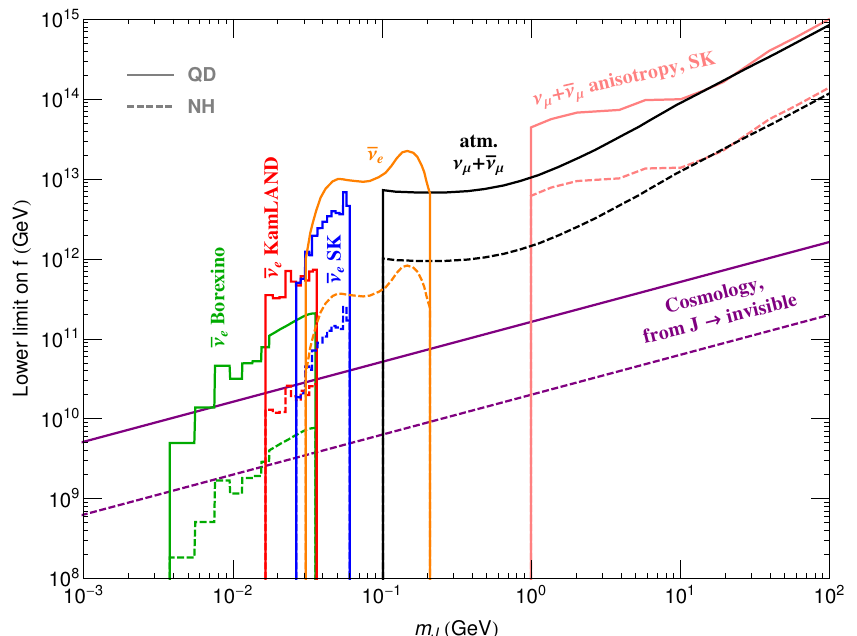
Figure 4 . Lower bound on the U(1) B (cid:0) L breaking scale f for majoron J DM, assuming QD (solid lines) or NH (dashed), IH lying in between. The purple exclusion comes from cosmological con- straints such as the CMB [60]. Adopted limits from supernova (cid:22) (cid:23) e searches come from Borexino [32] (green), KamLAND [33] (red), SK [34, 35] (blue), and reinterpreted SK data (orange) [26]. The black lines for m J > 0 : 1 GeV come from a comparison with atmospheric (cid:23) (cid:22) spectra [26], while pink shows the preliminary limit from a designated DM search using angular-anisotropy SK data [61]. using tri-bimaximal mixing values as an approximation. For the sake of clarity, it is there- fore su(cid:14)cient to discuss the limits for the regimes QD and NH in (cid:12)gure 4, as those associated to IH happen to fall in